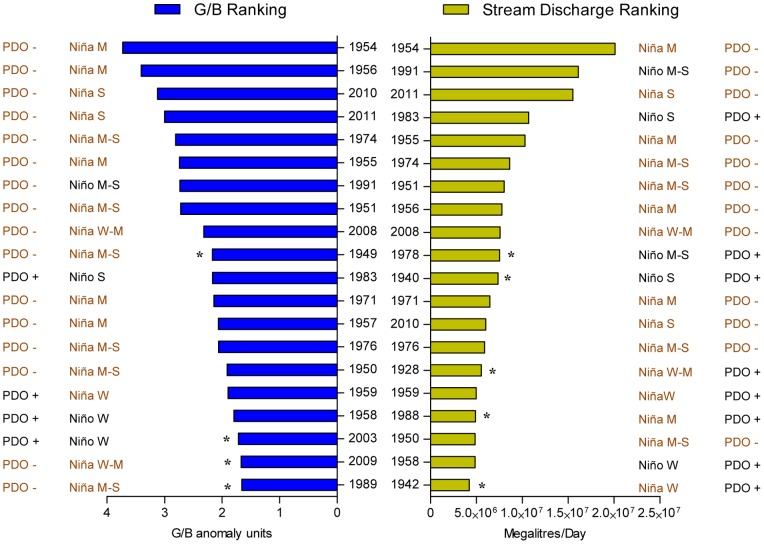
Comparison of the 20 highest G/B anomalies and monthly stream discharge rates for the period 1921–2011.Year, PDO phase (positive/negative) and ENSO state (Niño/Niña) is indicated for each record. Asterisks denote if a record is present only in one ranking. Stream discharge data from Queensland Department of Environment and Resource Management gauging stations on the Fitzroy River at The Gap (Station number 130005A) and Riverslea (130003A) (http://watermonitoring.derm.qld.gov.au/host.htm). W = weak, M = moderate, S = strong.